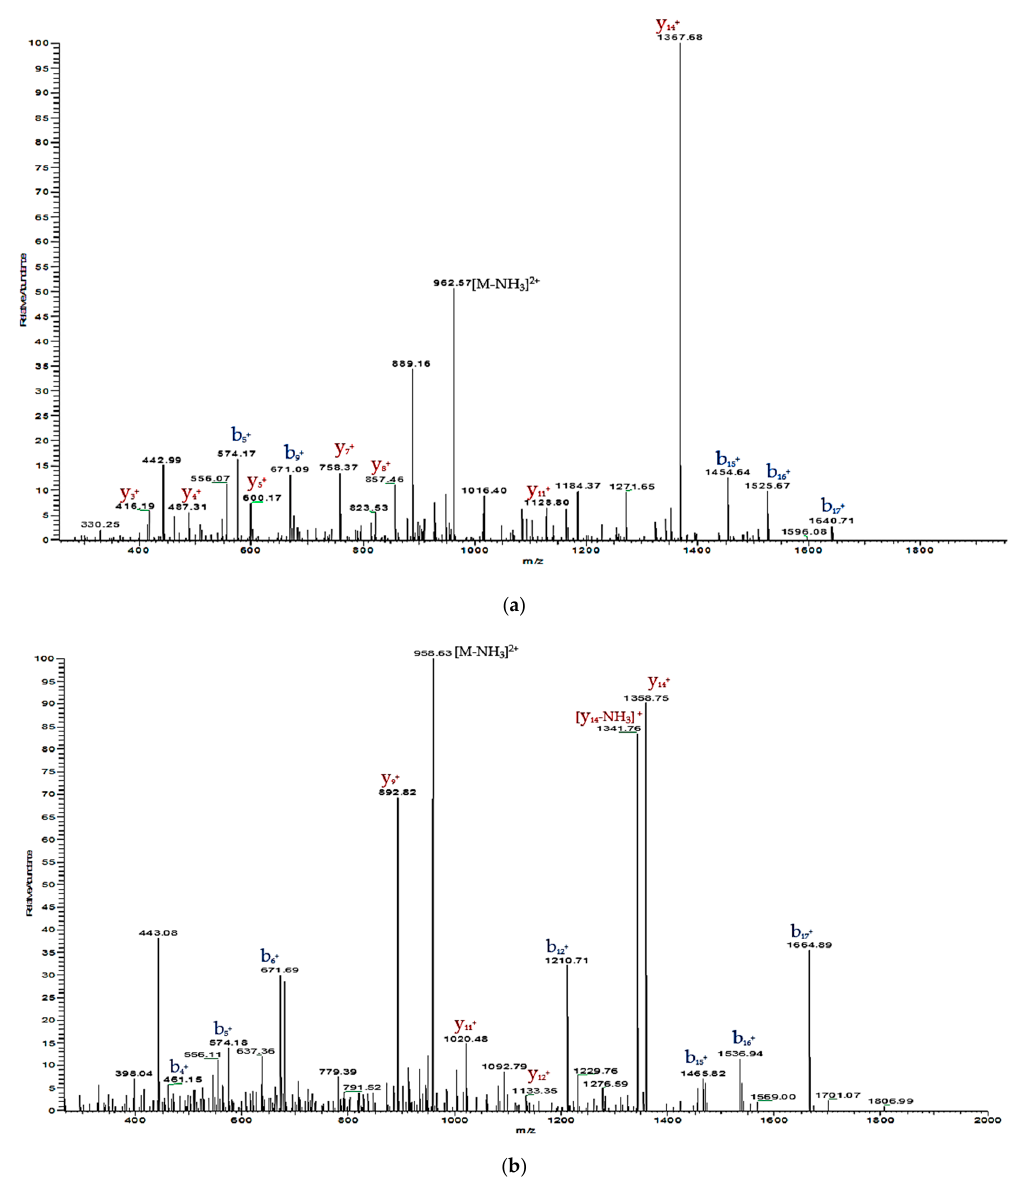
Figure 4. Annotated tandem mass (MS/MS) fragmentation spectra of ( a ) phylloseptin-PTa and ( b ) phylloseptin-PHa with observed b ions and y ions labelled in blue and red, respectively. Table 1. Predicted singly-charged b ions and y ions arising from MS/MS fragmentation of ( a ) phylloseptin-PTa and ( b ) phylloseptin-PHa. Actual fragment ions observed following MS/MS fragmentation are indicated in blue and red.